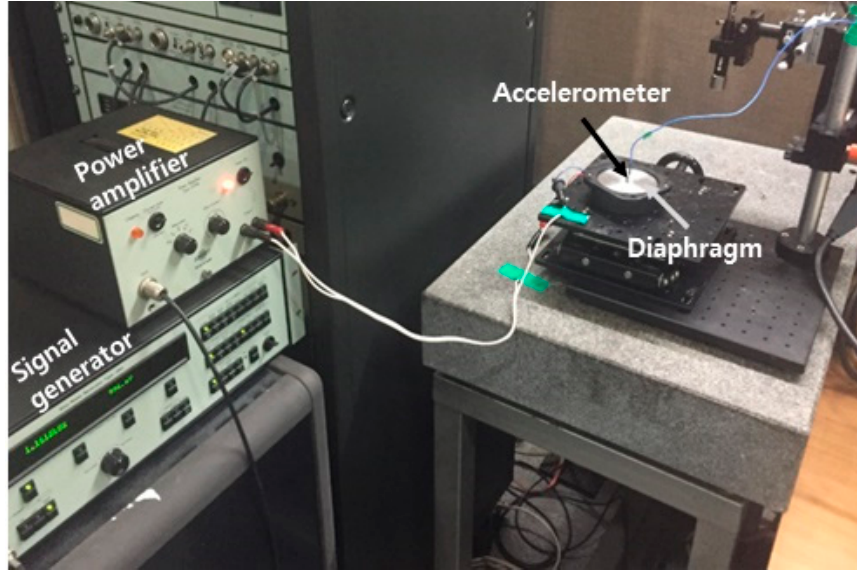
Figure 13. Set ‐ up of experiment for vibration response. Figure 13. Set-up of experiment for vibration response. Appl. Sci. 2021 , 11 , x FOR PEER REVIEW